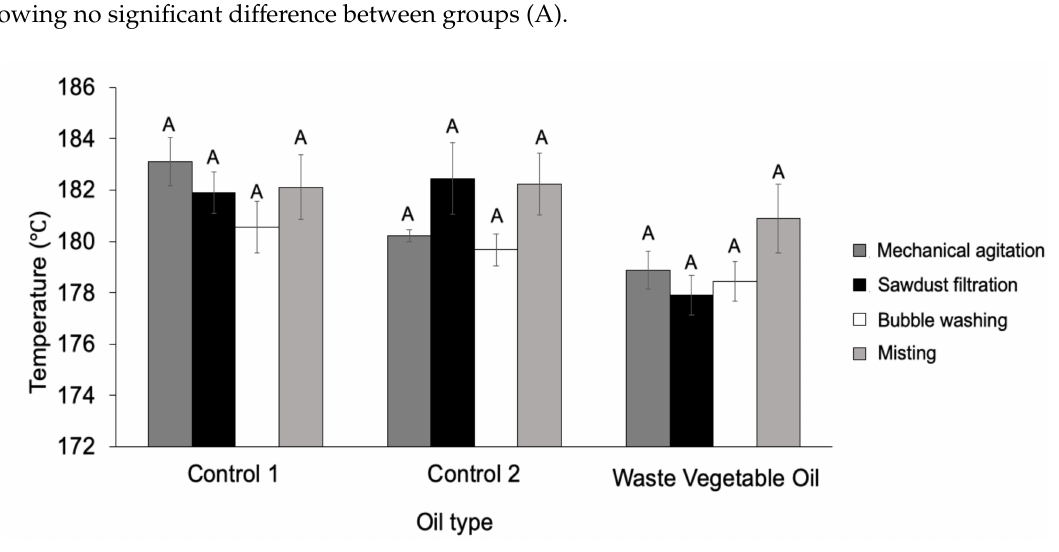
Figure 5. Flash point from biodiesel